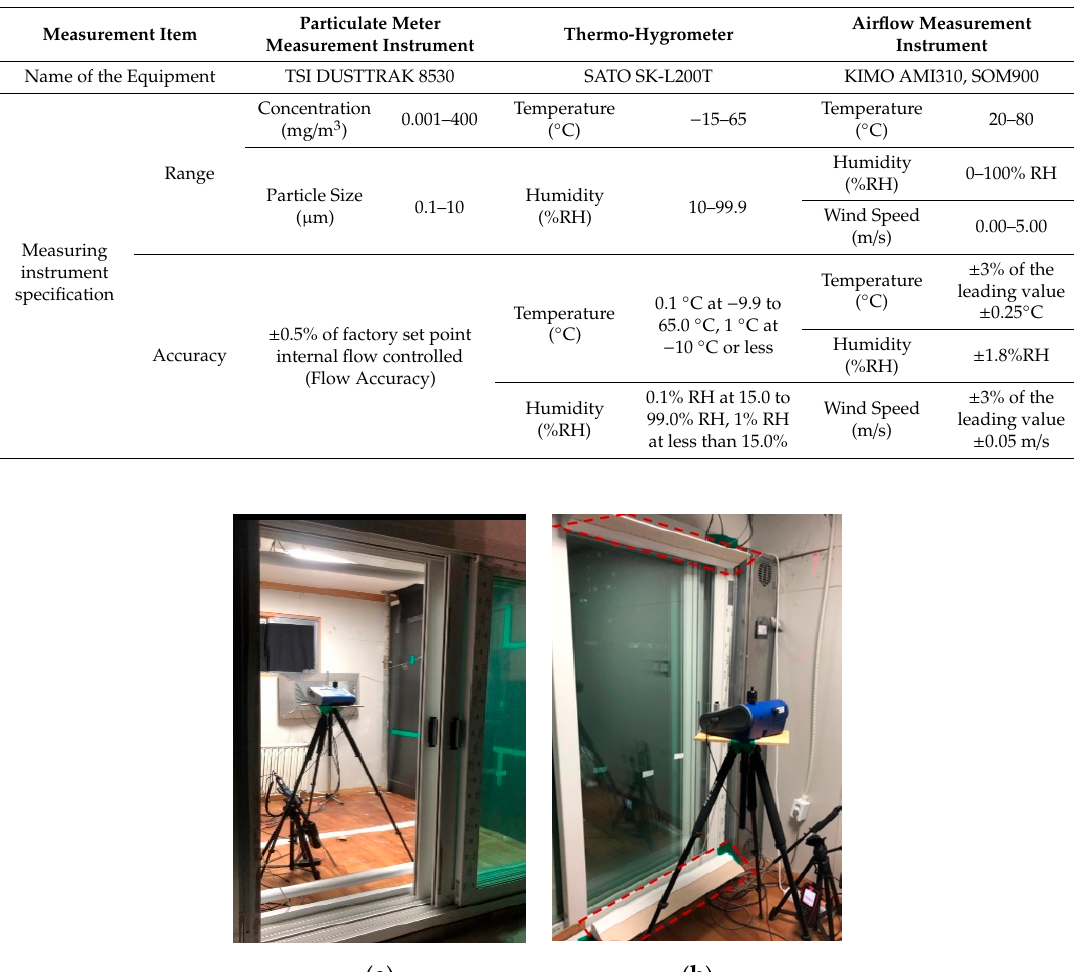
Figure 11. Plan and perspective view of the mock-up rooms. ( a ) mock-up plan view, ( b ) louver application location. Table 6. Specifications of the measurement equipment used in the tests. Table 5. Experimental method and location of the windcatcher.